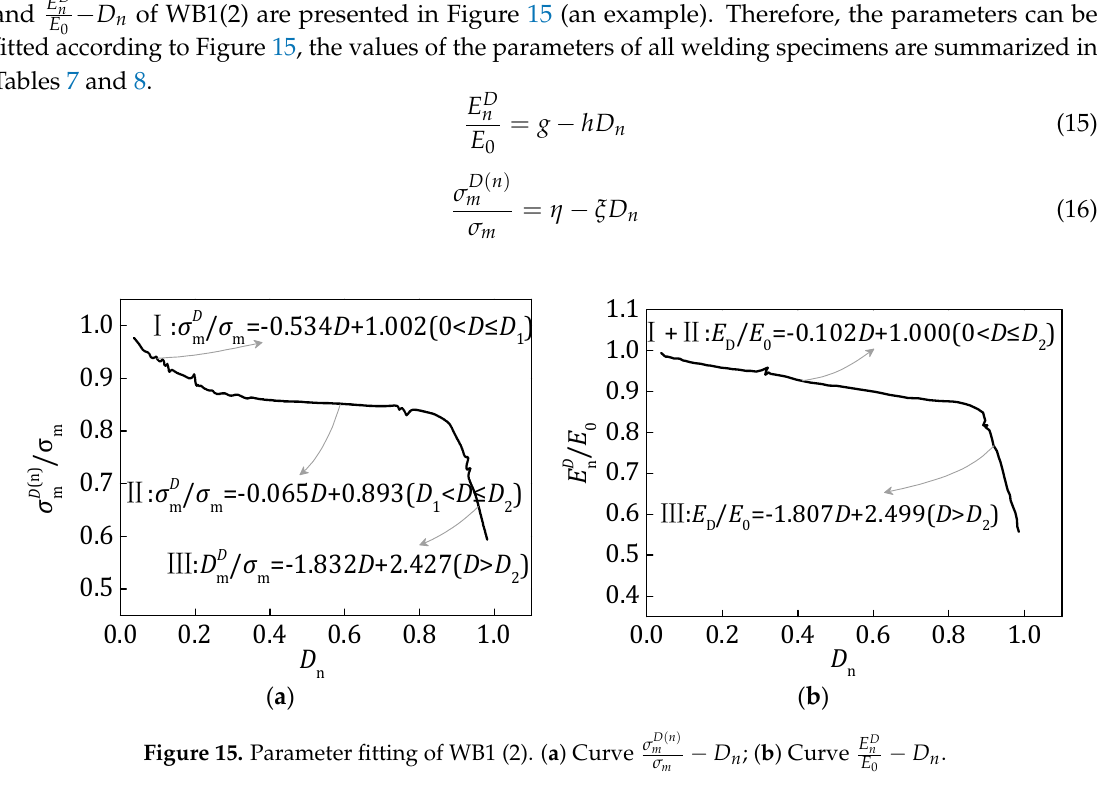
Figure 15. Parameter fitting of WB1 (2). ( a ) Curve σ